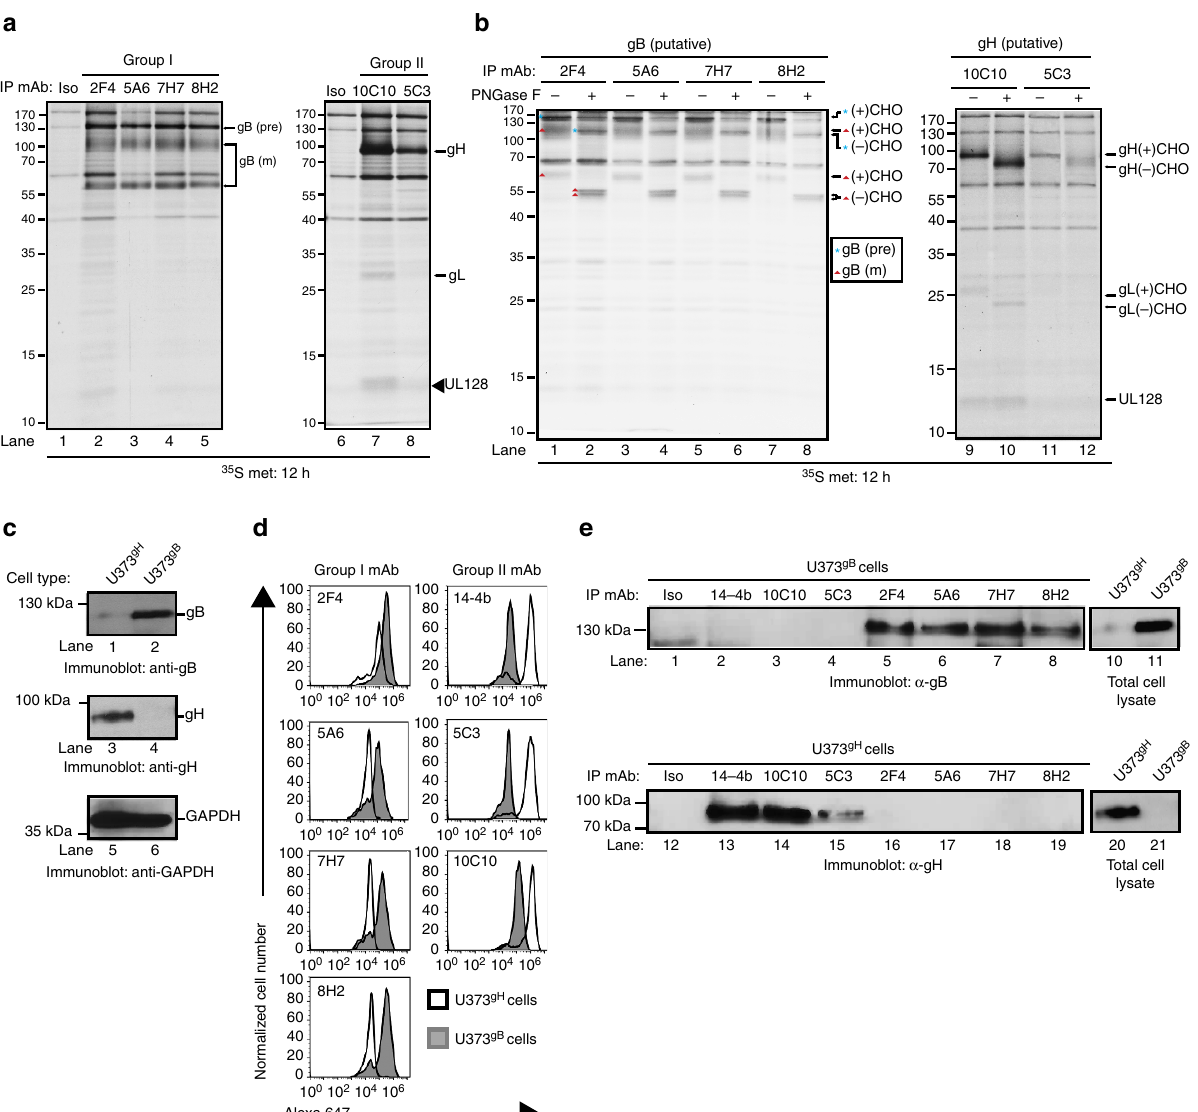
AD169 IE2-YFP infection (IC50 values: 0.24 m g ml (cid:2) 1 (5C3) to 4.2 m g ml (cid:2) 1 (7H7), while only the a -gH mAbs 10C10 and 5C3 neutralized TB40/E FLAG-YFP (IC50 values: 0.38 m g ml (cid:2) 1 and